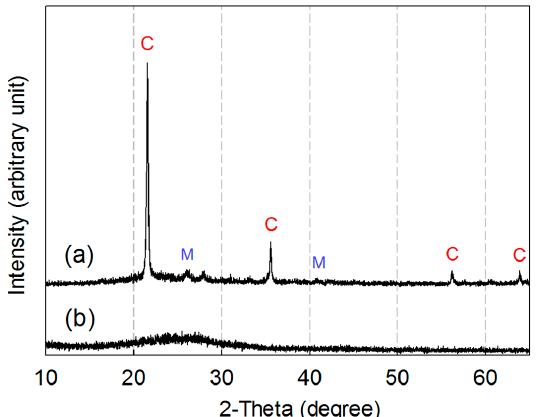
Figure 10. XRD patterns of ( a ) product sintered at 1100 °C for 3 h with ( b ) powdered gel obtained from leachate. C and M represent cristobalite and mullite, respectively.